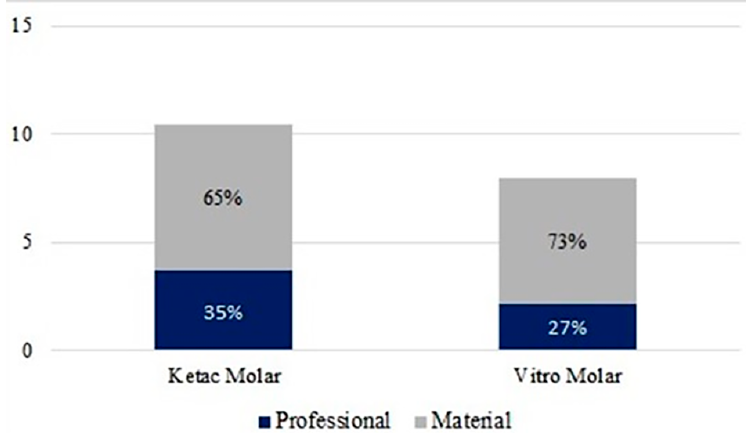
Figure 3- Distribution of material and professional